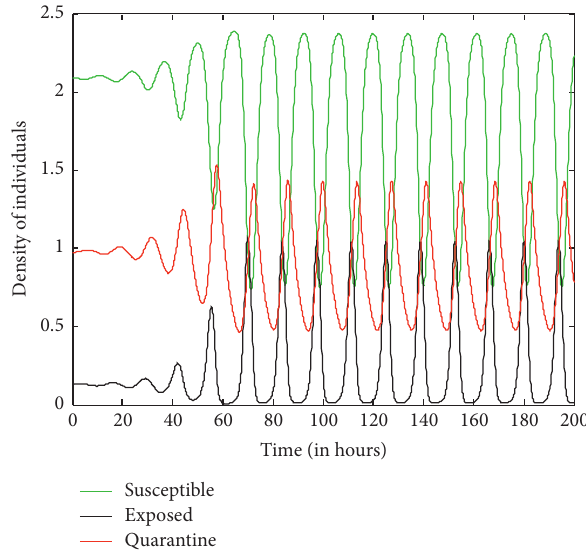
Figure 2: Transmission of COVID-19 in the diabetic/hypertension population.